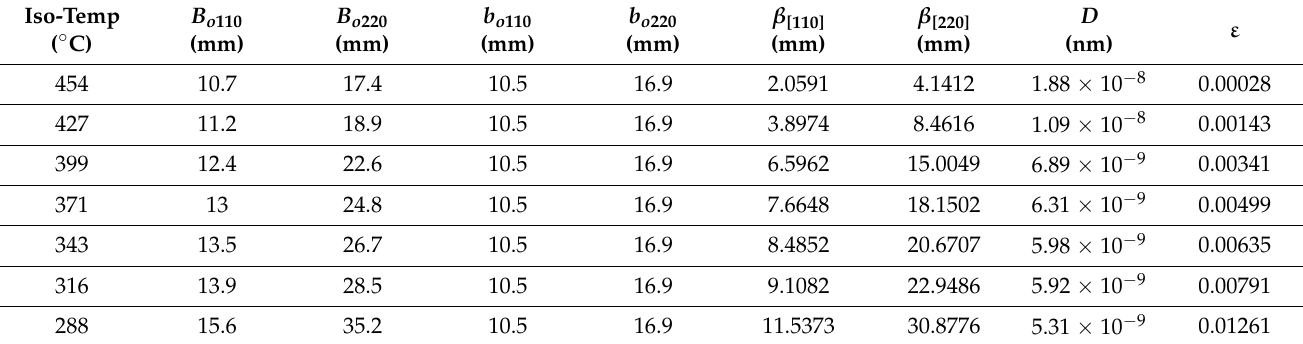
Table 1. X-ray line broadening, cystallite size D, and microstrain ε .